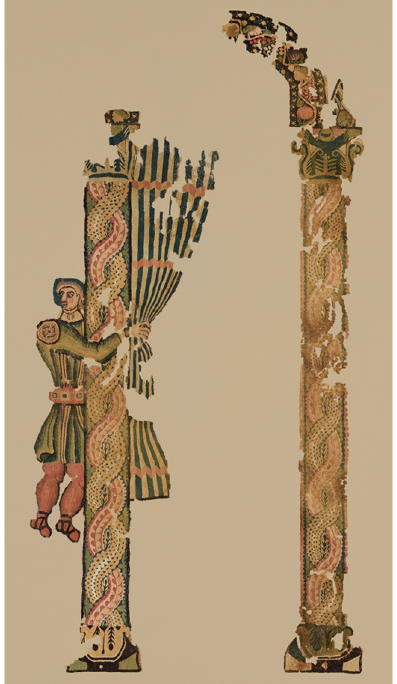
Figure 3. Fragment of a hanging: Ostiarius Drawing a Curtain , probably 5th century CE. Eastern Mediterranean, probably Egyptian, late Roman. Linen; tapestry-woven; linen and wool yarns; 188 × 93.5 cm (73 × 36 13/16 in.). Museum of Fine Arts, Boston, Charles Potter Kling Fund, 57.180. Photograph © [2022] Museum of Fine Arts, Boston, MA, USA.